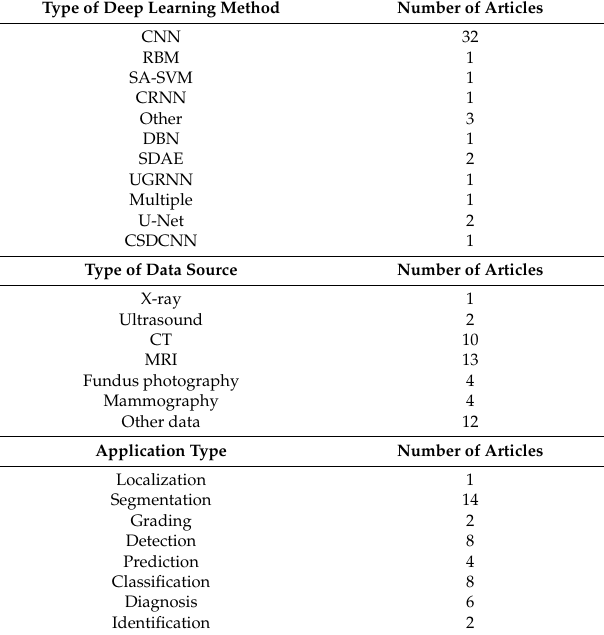
Table 3. Synthesis of articles by type of deep learning method, data source and